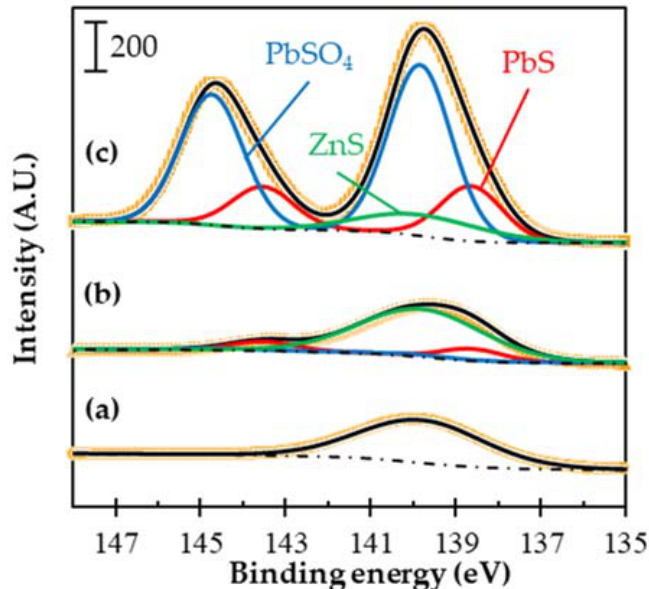
Figure 9. XPS Pb4f7/2 spectra of ( a ) raw ZnS, ( b ) ZnS/PbSO 4 with EDTA pretreatment, and ( c ) ZnS/PbSO 4 without EDTA pretreatment. Table 3. XPS peak parameters for Pb4f 7/2 spectra and relative abundances of Pb species.